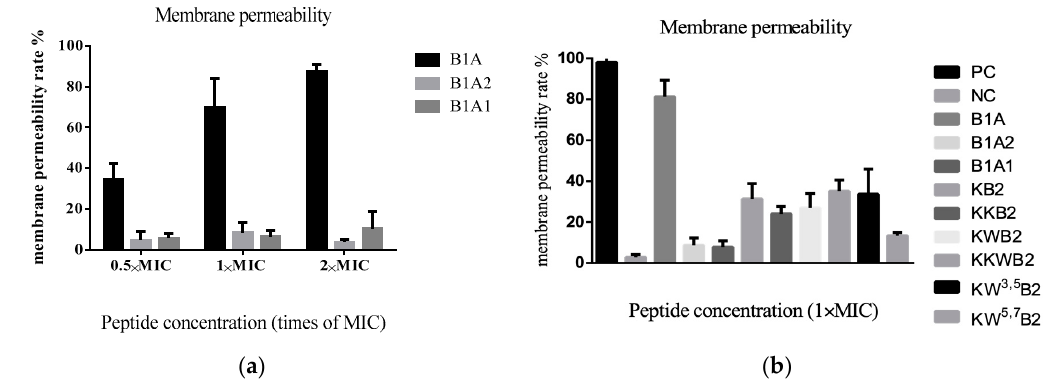
Figure 5. ( a ) Cell membrane e ff ects of B1A, B1A1, and B1A2 on S. aureus . ( b ) Cell membrane e ff ects of